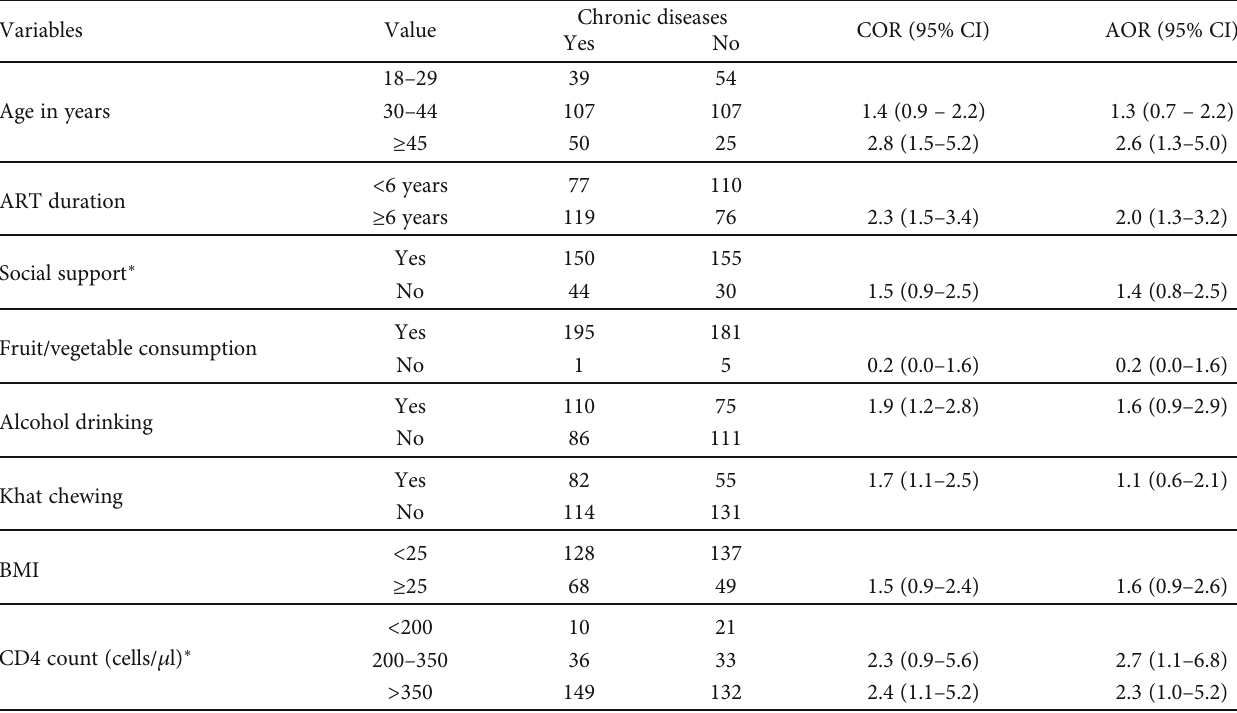
Table 5: Risk factors of having a chronic disease among people living with HIV at HUCSH, April 2016.